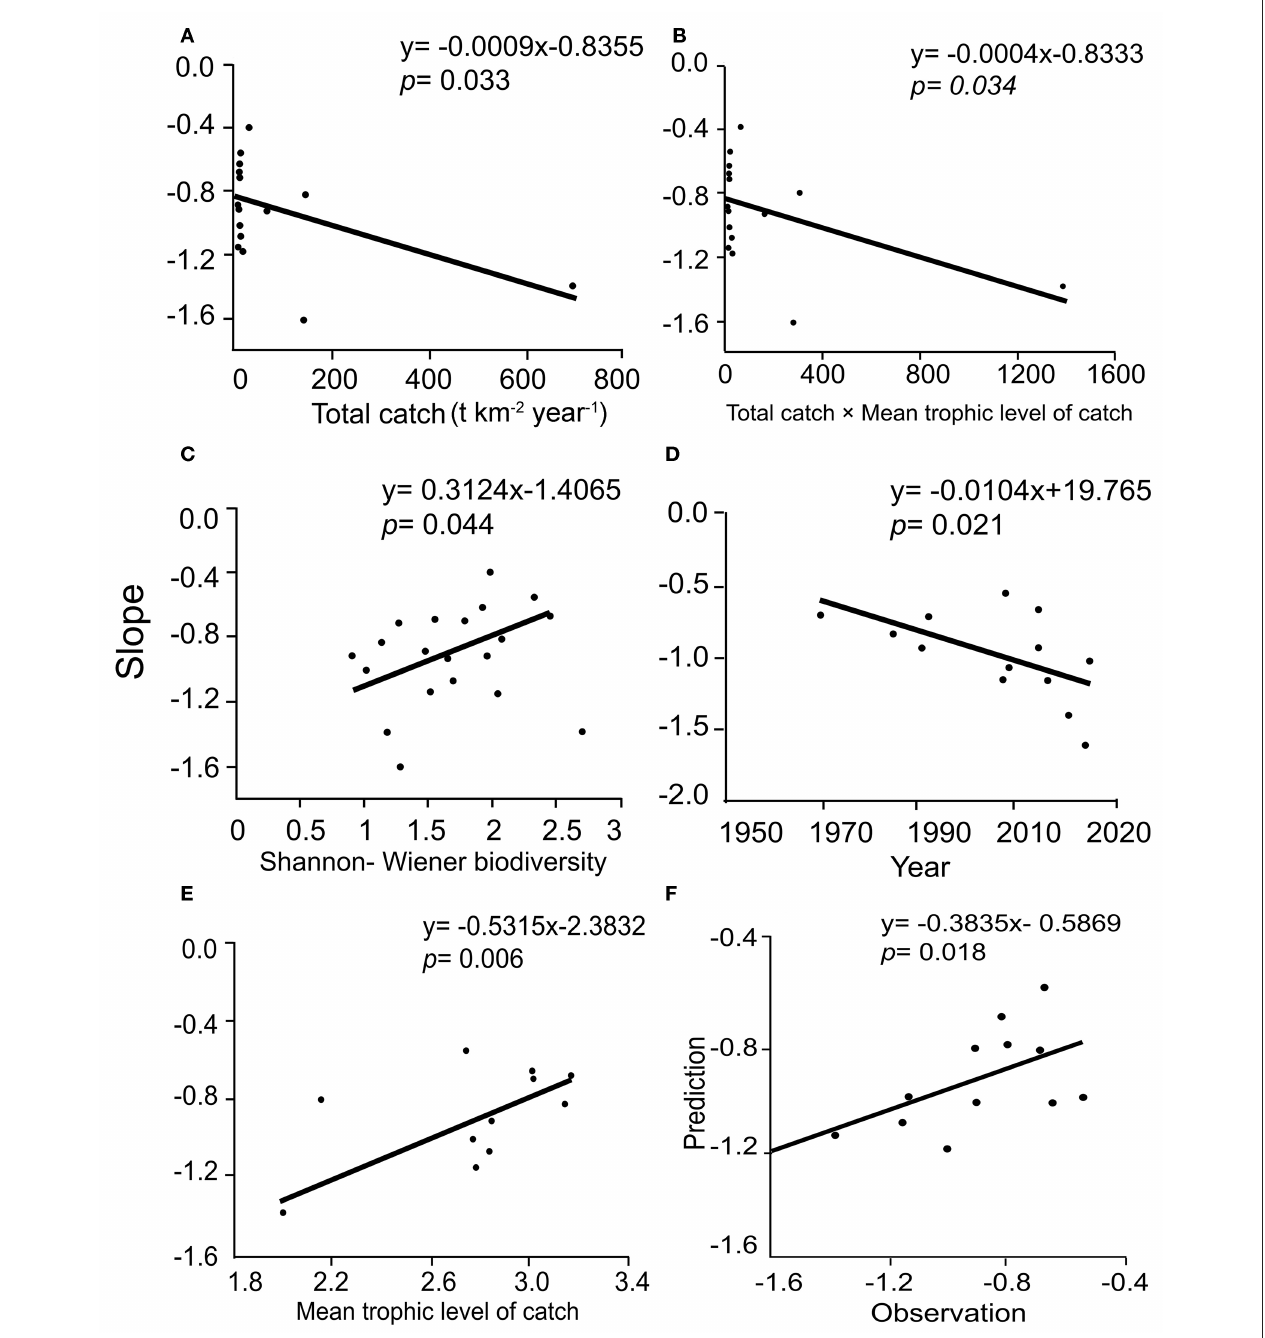
FIGURE 6 | Regression of the slopes of particle size distributions in 19 Ecopath models of Chinese coastal ecosystems against explanatory factors. (A) Total catch; (B) Total catch × mean trophic level; (C) Shannon-Wiener biodiversity index; (D) Year; (E) Mean trophic level of catch; (F) Predicted vs observed slope (see